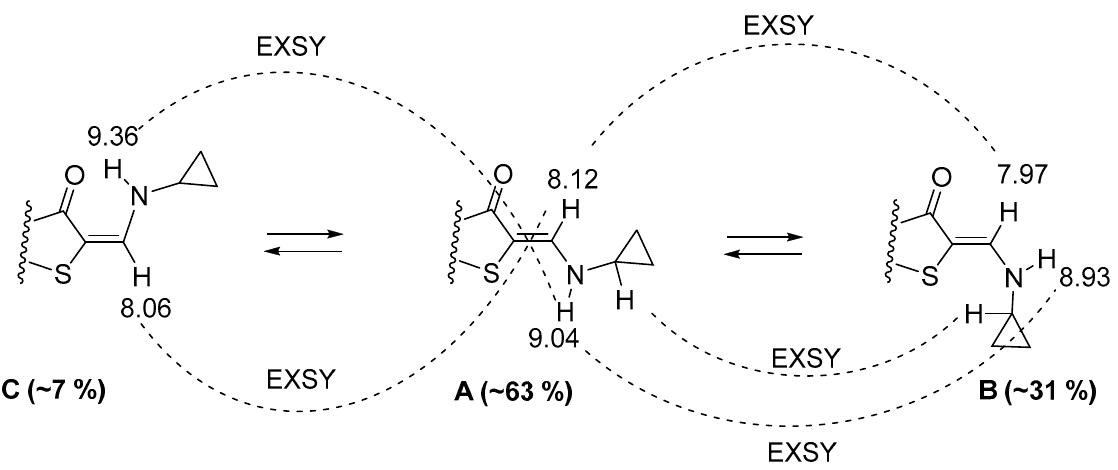
Figure 4. Interpretation of exchange cross-peaks between A , B and C isomers of 5c . In the 13 C-NMR spectrum of 5c signals of A and B form and some signals of C form could be identified (Scheme 4).